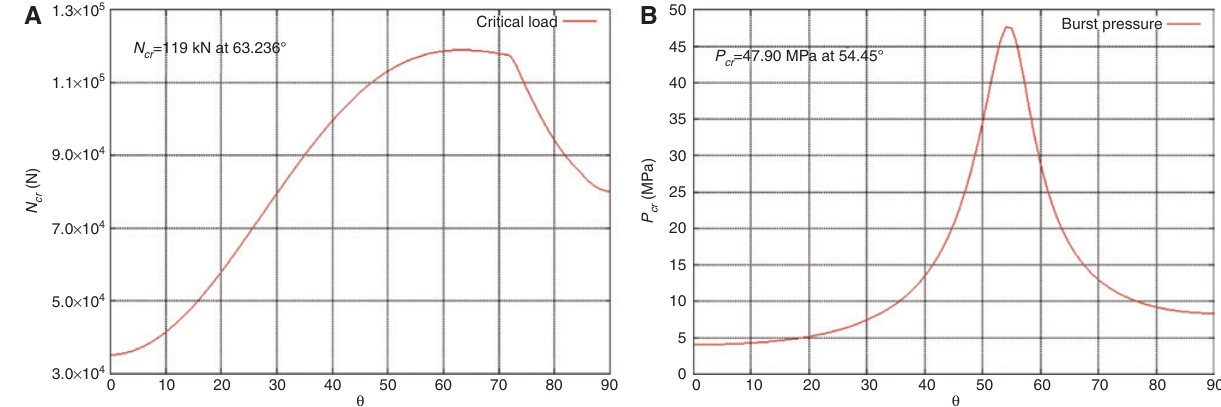
Figure 1: Variation of the buckling load in a rectangular plate and the critical pressure in a cylindrical pressure vessel depending on the fiber orientation. Case of a single